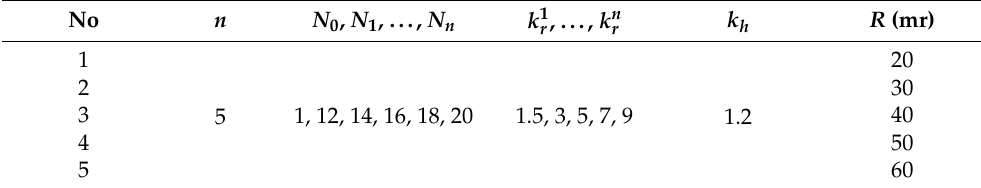
Table 1. Parameter combination of different support